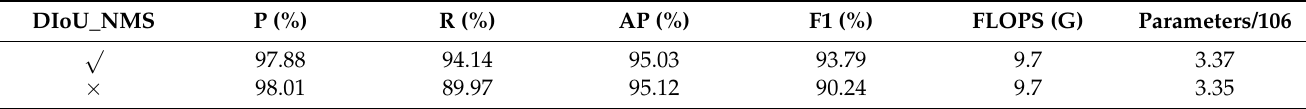
Table 10. Ablation study of YOLOv5-AC with and without DIoU_NMS.